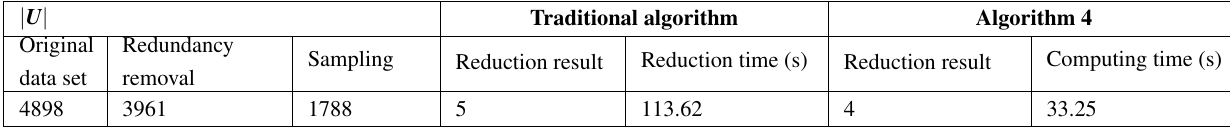
Table 5 Comparison on the effect of reduction for Winequality data set Traditional algorithm Algorithm